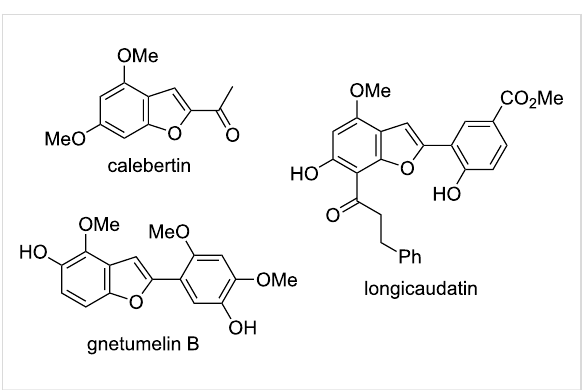
Figure 1: Some representative dihydroxybenzofuran derived natural products.